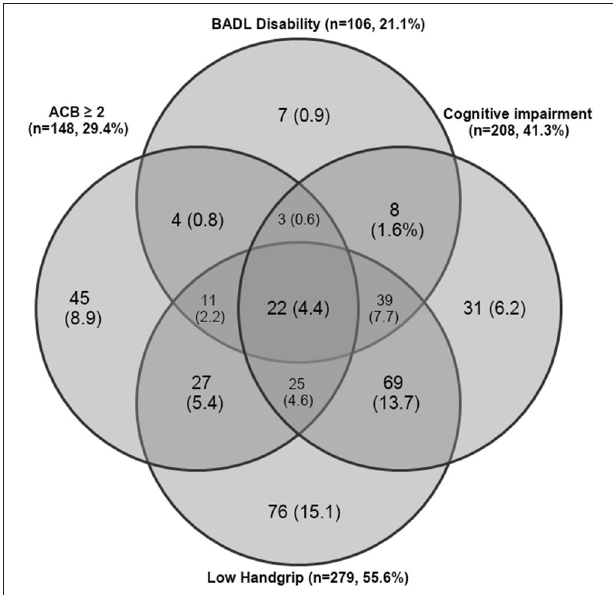
FIGURE 1 | Venn diagram showing overlapping of study risk factors significantly associated with mortality in the study